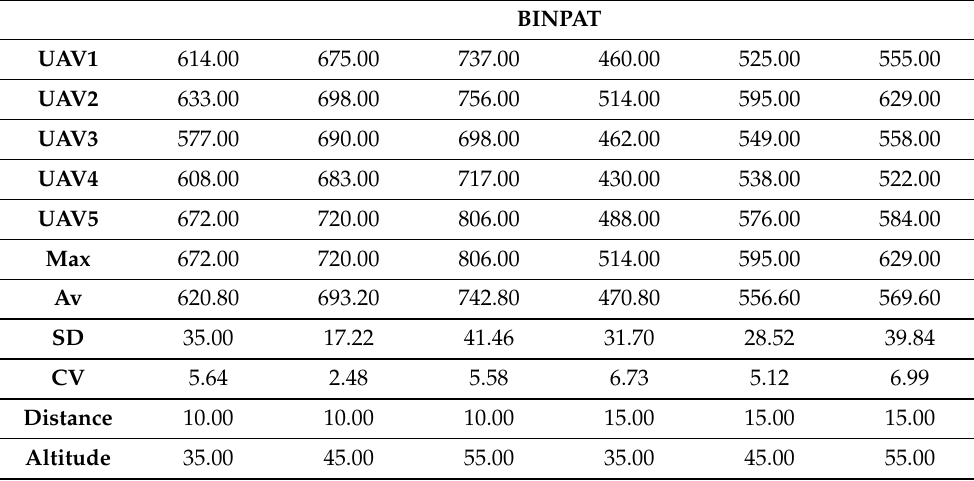
Table A11. Time results using the BINPAT algorithm and five UAVs in a long-track scenario.